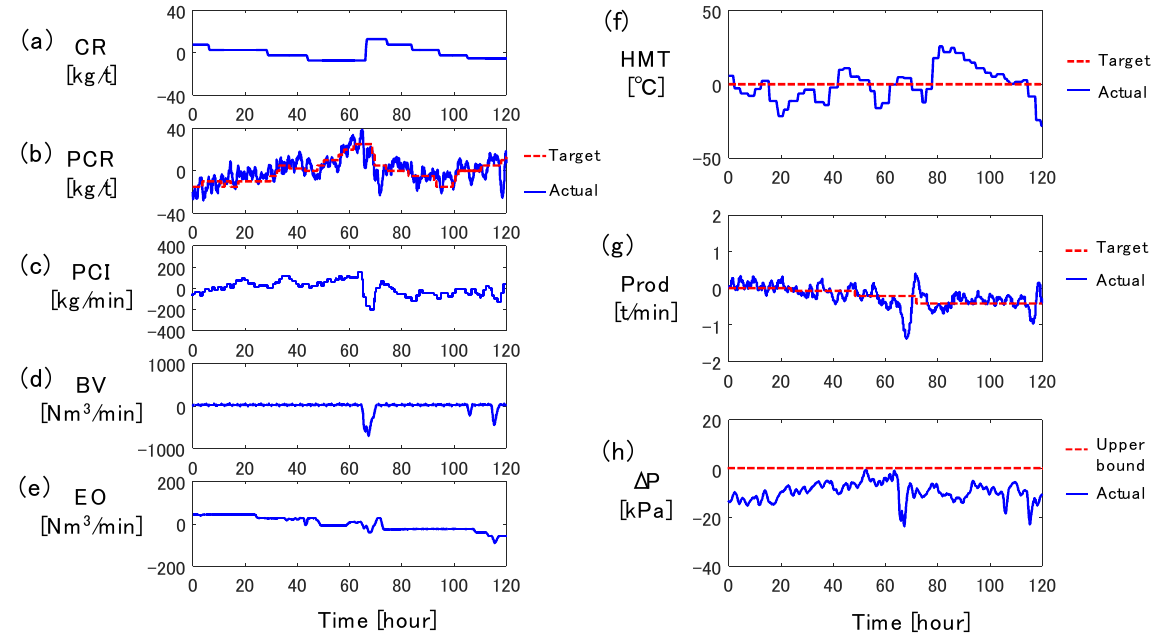
Figure 2. Example of manual operation of blast furnace: ( a ) coke rate, ( b ) pulverized coal rate, ( c ) PC flow rate, ( d ) blast volume, ( e ) enrichment oxygen flow rate, ( f ) hot metal temperature, ( g ) production rate, ( h ) pressure